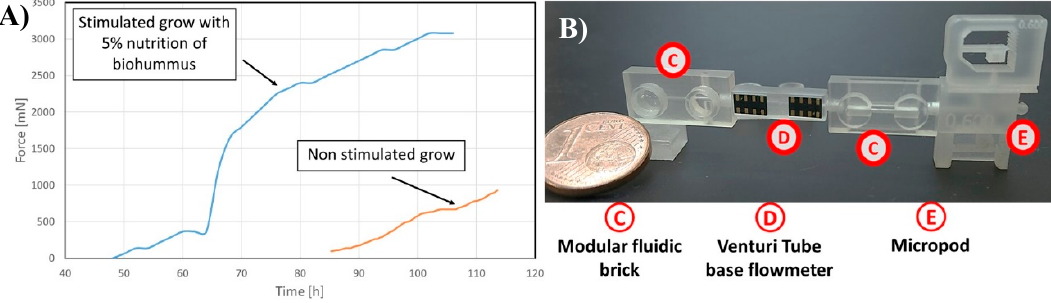
Figure 5. Influence of stimulate (bio-hummus) on seed grow measured by micropot, ( A ) force-time. ( B ) experimental